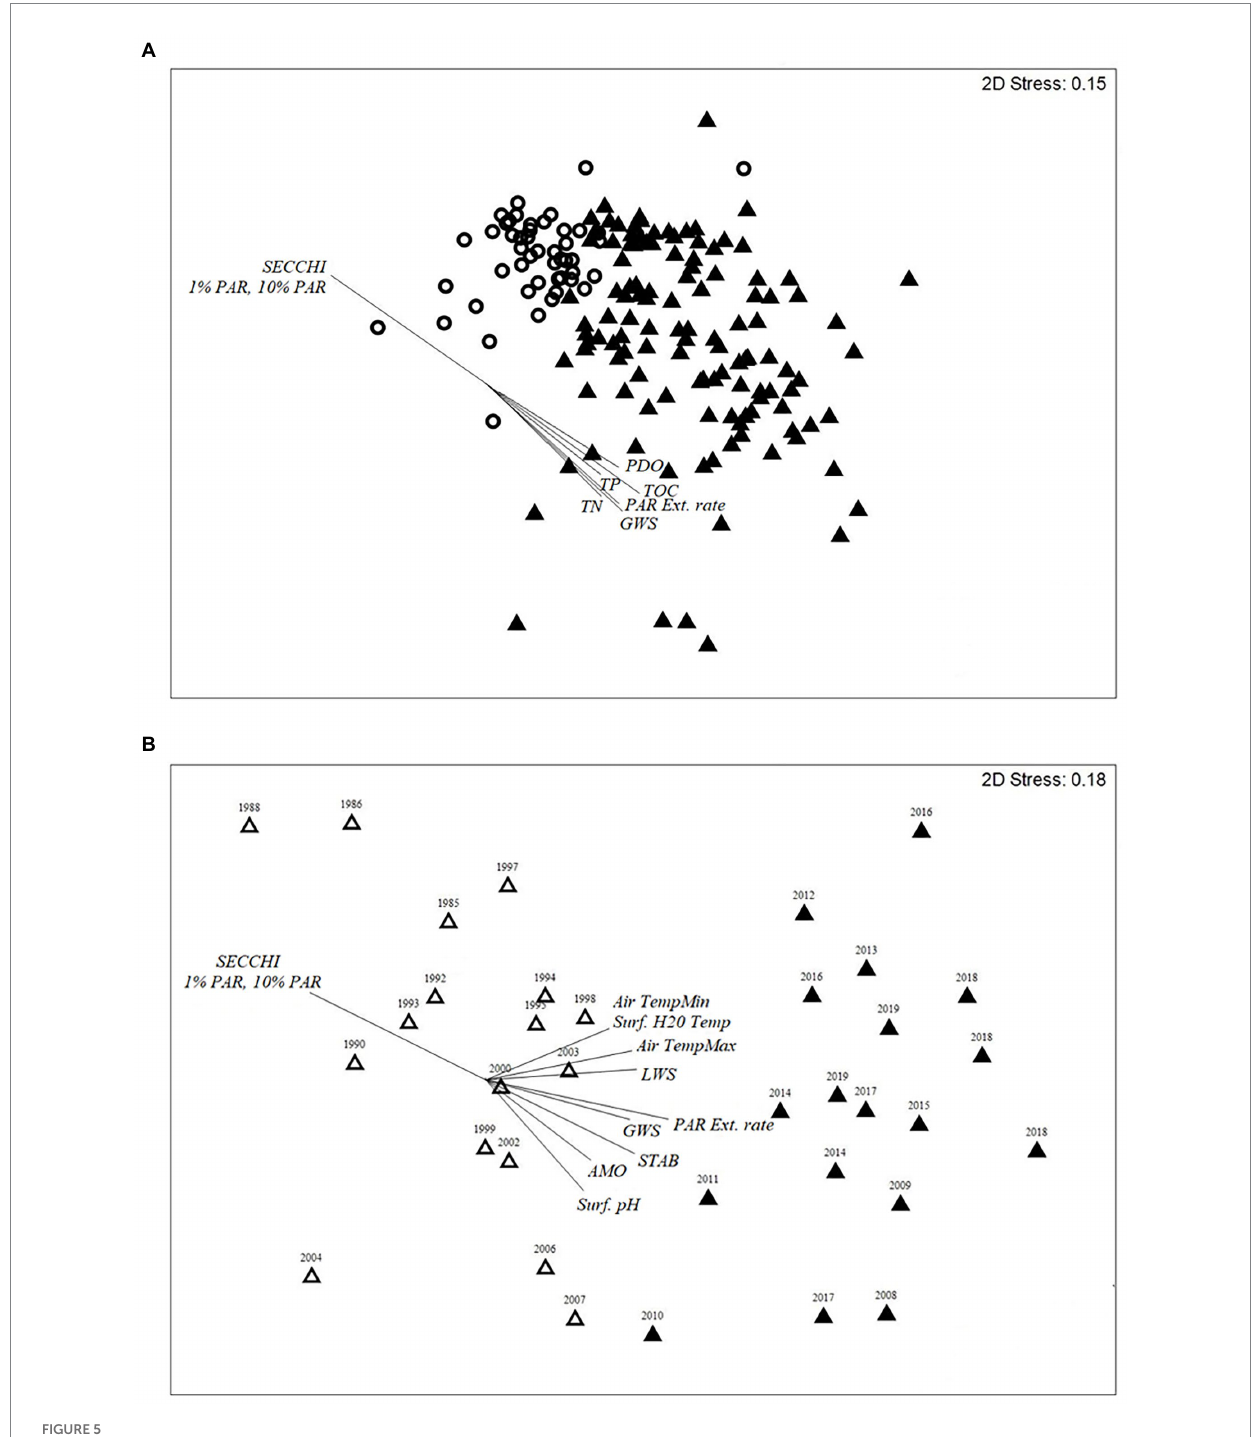
FIGURE 5 (A,B) Two-dimensional nMDS ordination biplot of (A) modern calibration diatom taxon realitive abundances and (B) of paleo calibration diatom taxon relative abundances. (A) nMDS plot of the Monthly record (2005–2019) of the two diatom-transprency phases; clear (circle) and dark (triangle). Vectors for the climate, hydrological and physiochemical parameters with a R 2 > 0.5 are provided for plot (A) . (B) nMDS plots of the two diatom-inferred paleo-diatom- transparency phases; dark (dark triangle) and clear (clear triangle, and contains some duplicate years because of the 210 Pb age). Vectors for plot (B) are nutrient and silica flux rates (phosphorus, nitrogen, carbon, silica), nutrient ratios (C:N, N:P), 210 Pb age of sample, ẟ 15 N and ẟ 13 C values, Shannon diversity index (SDI), the measured (Subzone 2a–3b) and predicted AMO (Gray et al., 2004 – Subzone 1a–1b), and Secchi depth (observed Secchi depth used since 1985, middle of subzone 3a-3b, and the diatom-inferred Secchi depth Secchi Depth from the paleo model was used for subzones 1a – middle